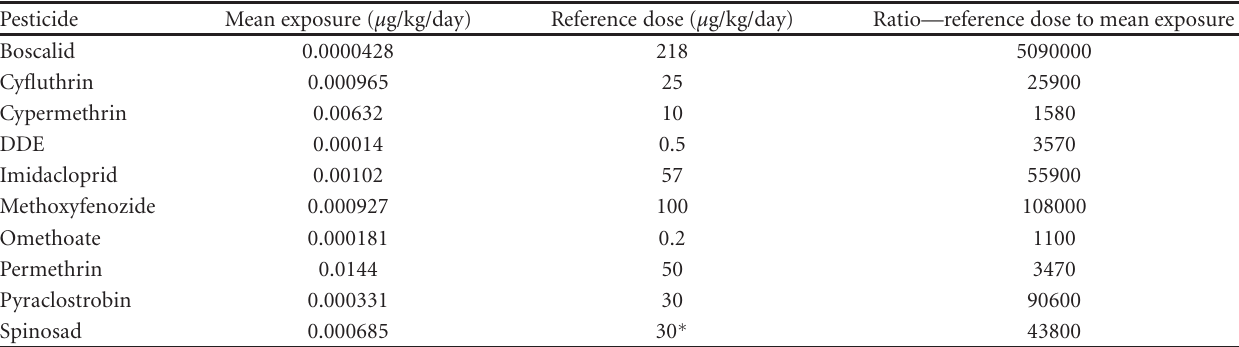
Table 12: Exposure estimates of the ten most frequently detected pesticides on spinach.